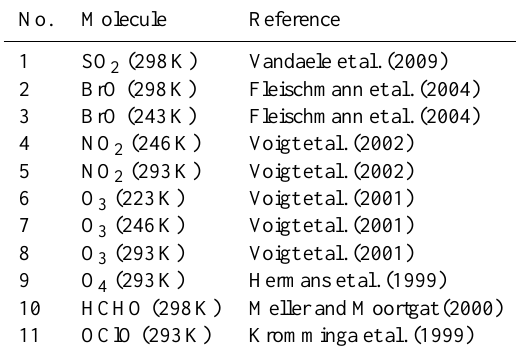
Table 5. List of trace gas references used for the DOAS